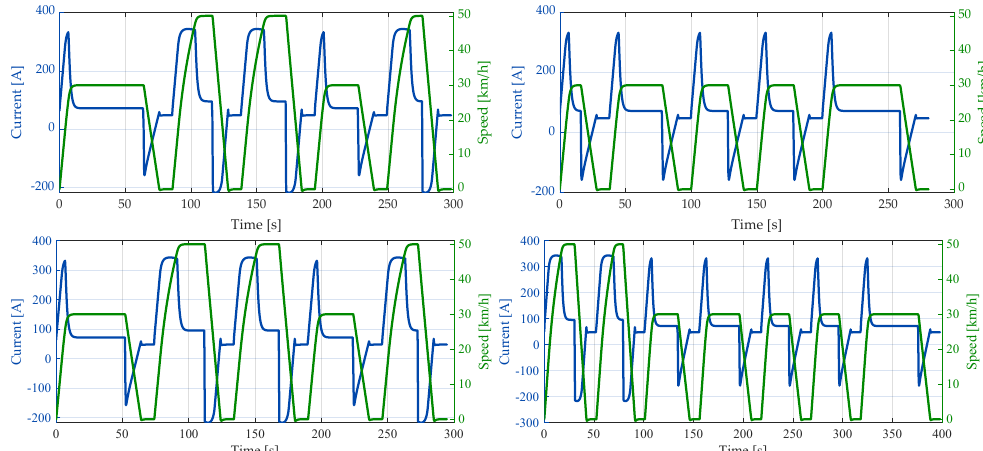
Figure 6. Traction diagram speed (green traces) and currents (blue traces) of conventional trolleybuses covering the paths of line 14 (upper figures) and line 15 (bottom figures). Outward journeys are on the left side; return journeys on the right